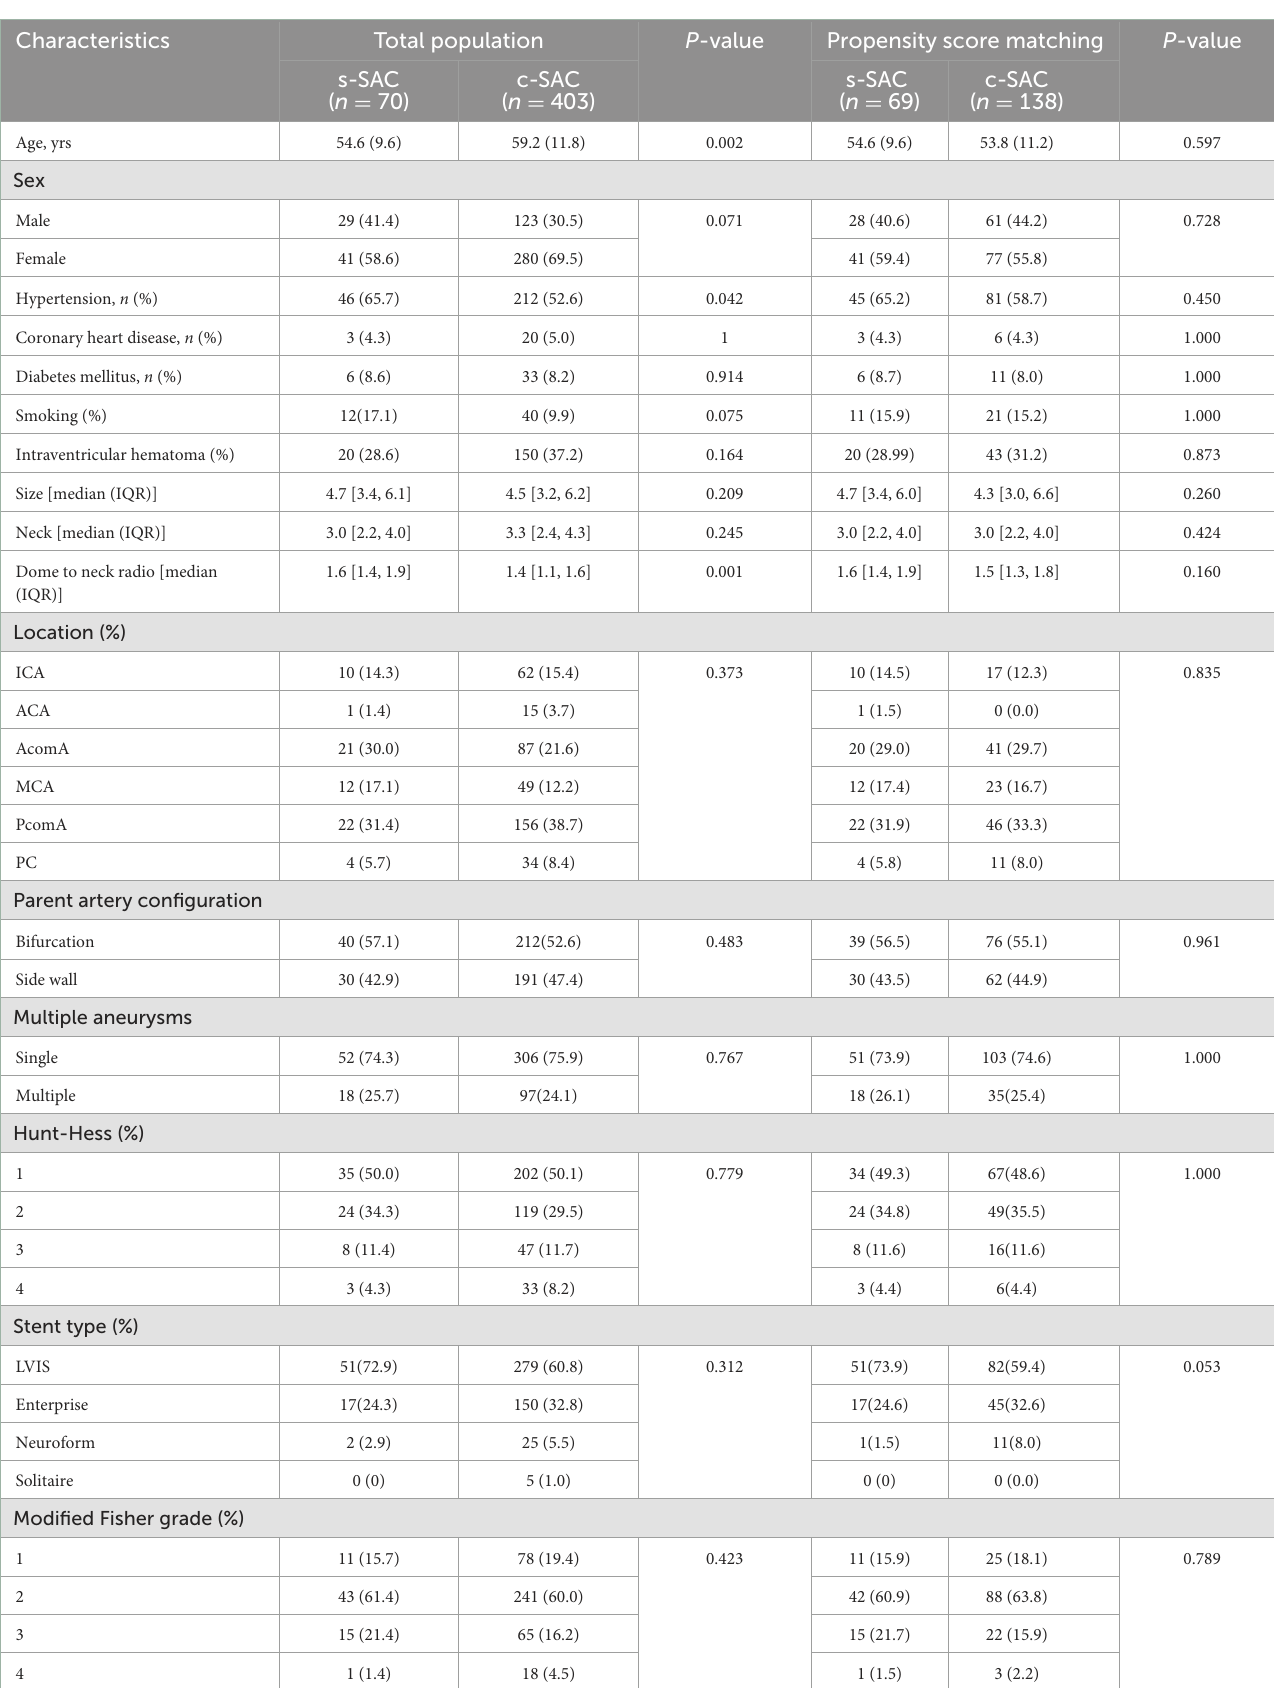
TABLE 1 Angiographic and clinical characteristics before and after propensity score matching ( n =